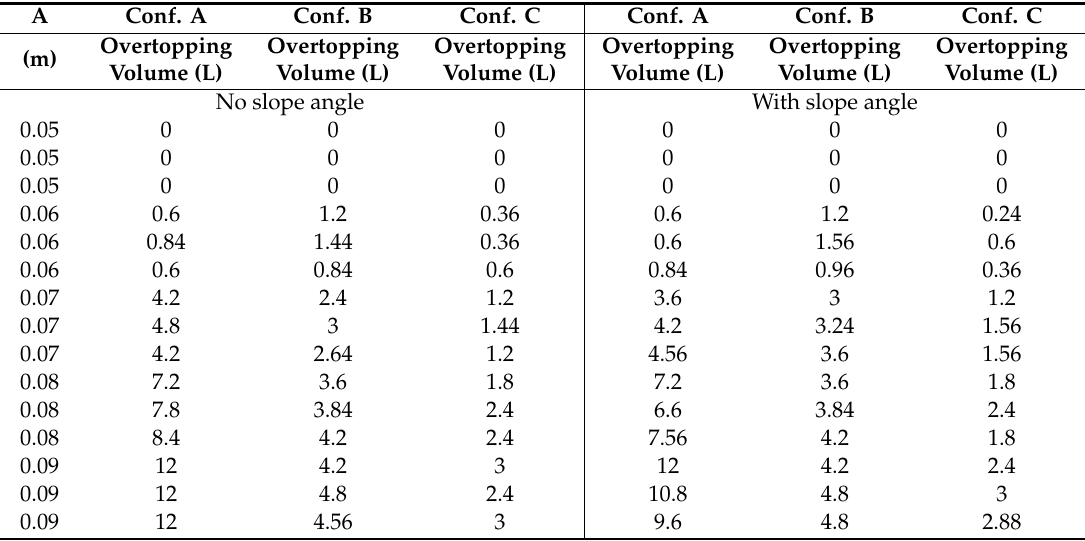
Table 5. Experimental testing parameters collected for sine wave (A = amplitude) with and without slope